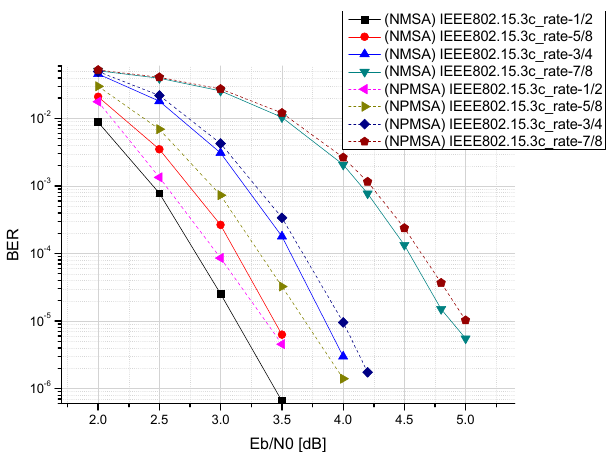
Figure 12. Comparison of decoding performance of different algorithms in IEEE 802.11ad.